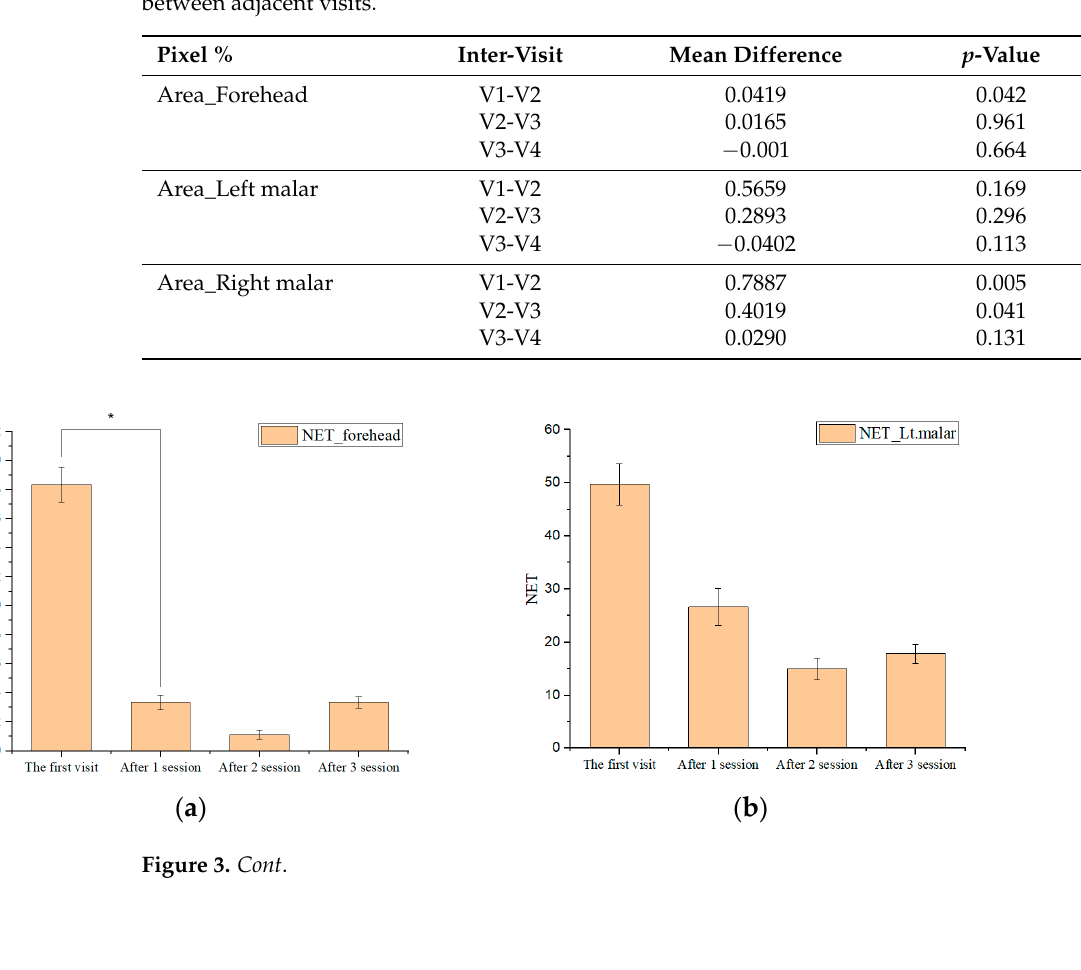
Table 4. Mean difference of NET (number of lesions exceeding the erythema threshold) between adjacent visits. Table 5. Mean difference of pixel % (summation of the area exceeding the erythema threshold) be- tween adjacent visits.